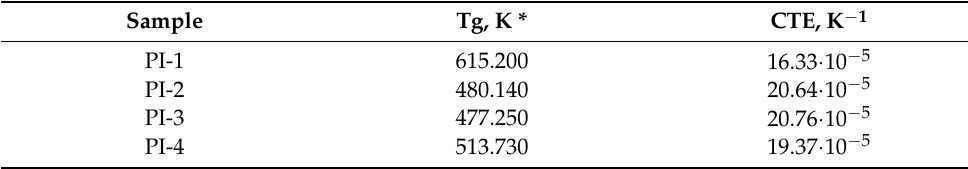
Table 1. The values of the vitrification temperature and coefficient of thermal expansion for the studied